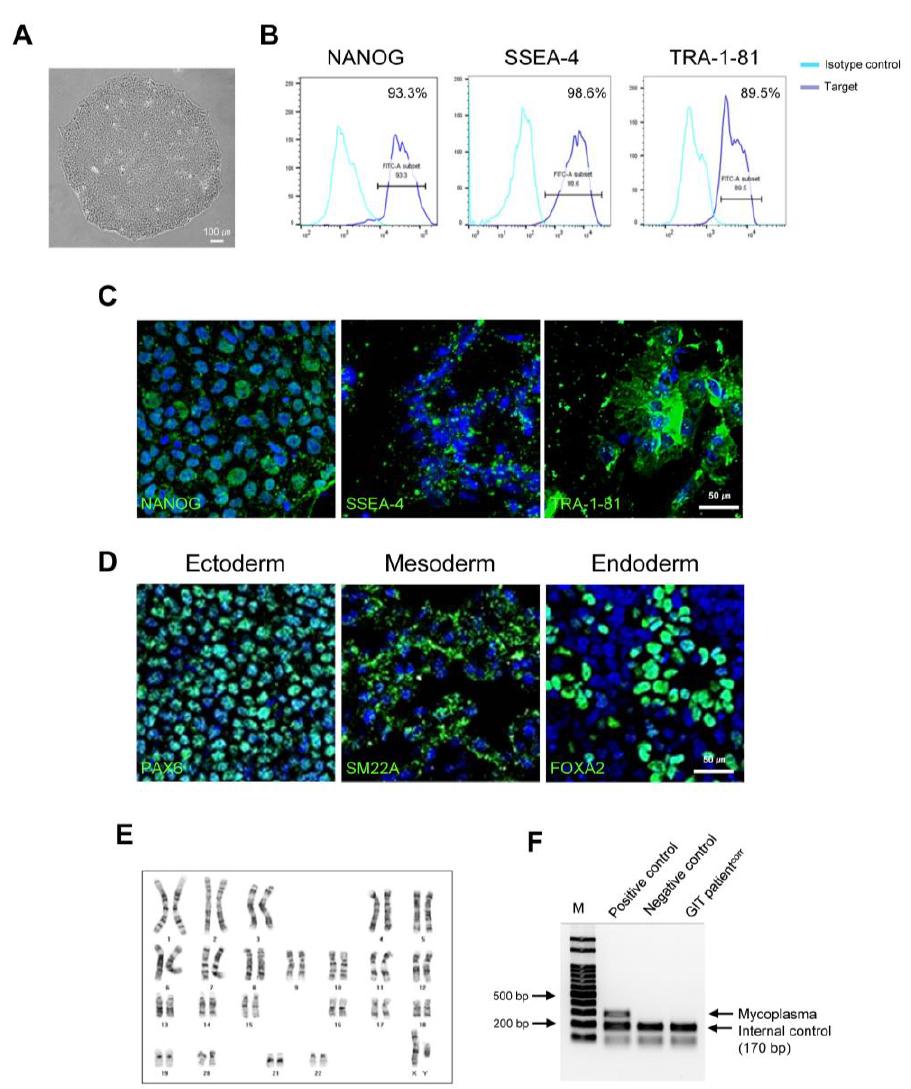
Figure 2. Characterization of corrected iPSCs from GIT patients (CMC-GIT-001 corr ). ( A ) Morphology of corrected GIT patient iPSCs (CMC-GIT-001 corr ). ( B ) Flow cytometry analysis of cells expressing NANOG, SSEA-4, and TRA-1-81. ( C ) Representative immunofluorescence image of pluripotency markers NANOG, SSEA-4, and TRA-1-81. ( D ) Immunofluorescence staining of three germ layer markers. Ectoderm, mesoderm, and entoderm differentiation were detected by PAX4, SM22a, and FOX2A, respectively. Scale bar = 50 µ m. ( E ) Chromosome karyotyping of CMC-GIT-001 corr hiPSCs. ( F ) Mycoplasma detection by PCR,